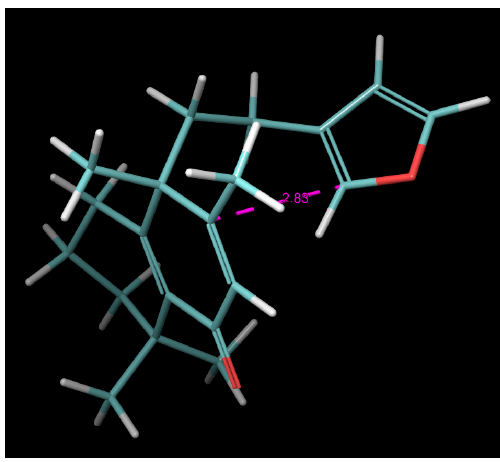
Figure 2. Representative minimum-energy conformer of compound 3.